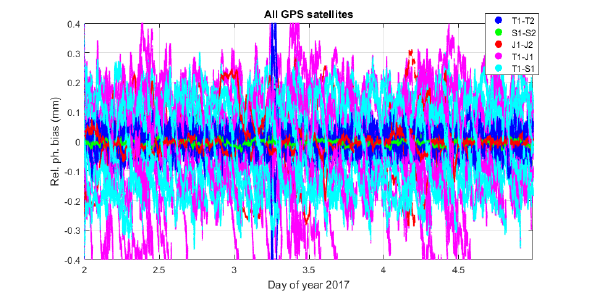
Figure 7: Temporal variations for all GPS satellites for various re- ceiver combinations